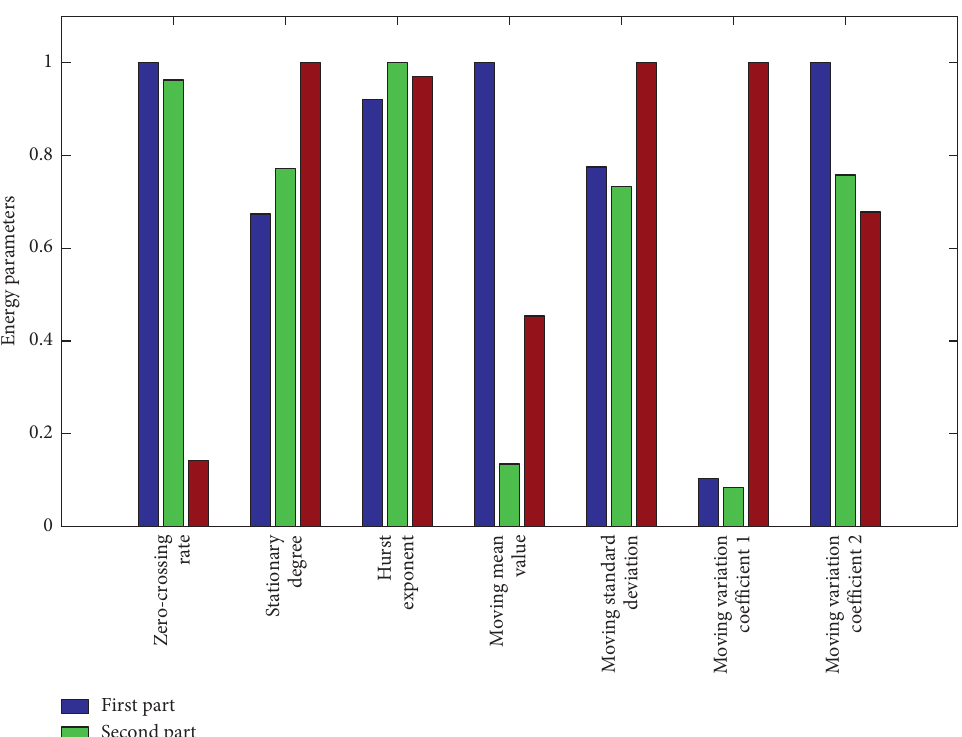
Figure 11: Nonstationarity energy index of mechanical fault